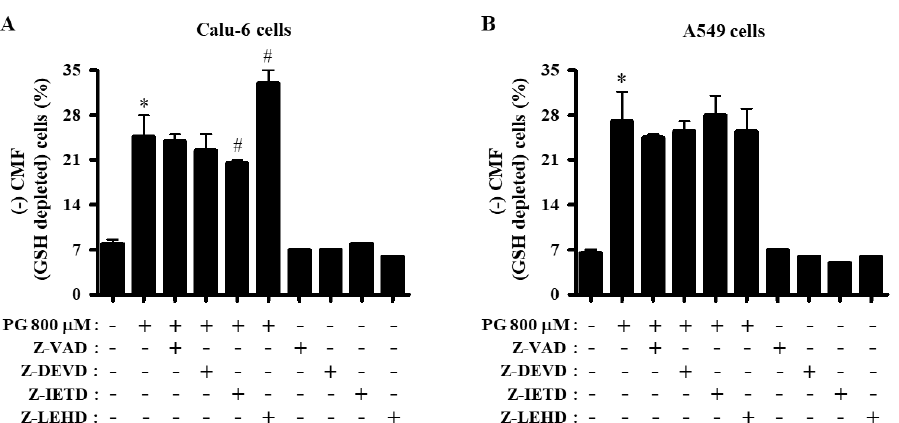
Figure 8. Effects of PG and caspase inhibitors on intracellular GSH depletion in lung cancer cells. Exponentially growing cells were incubated with 800 µ M PG and/or each caspase inhibitor (15 µ M) for 24 h. Intracellular GSH levels in lung cancer cells were measured using a FACStar flow cytometer. ( A , B ): Graphs show the percentage of negative CMF (GSH-depleted) Calu-6 cells ( A ) and A549 cells ( B ). * p < 0.05 compared with the PG-untreated control group. # p < 0.05 compared with cells treated with PG only.